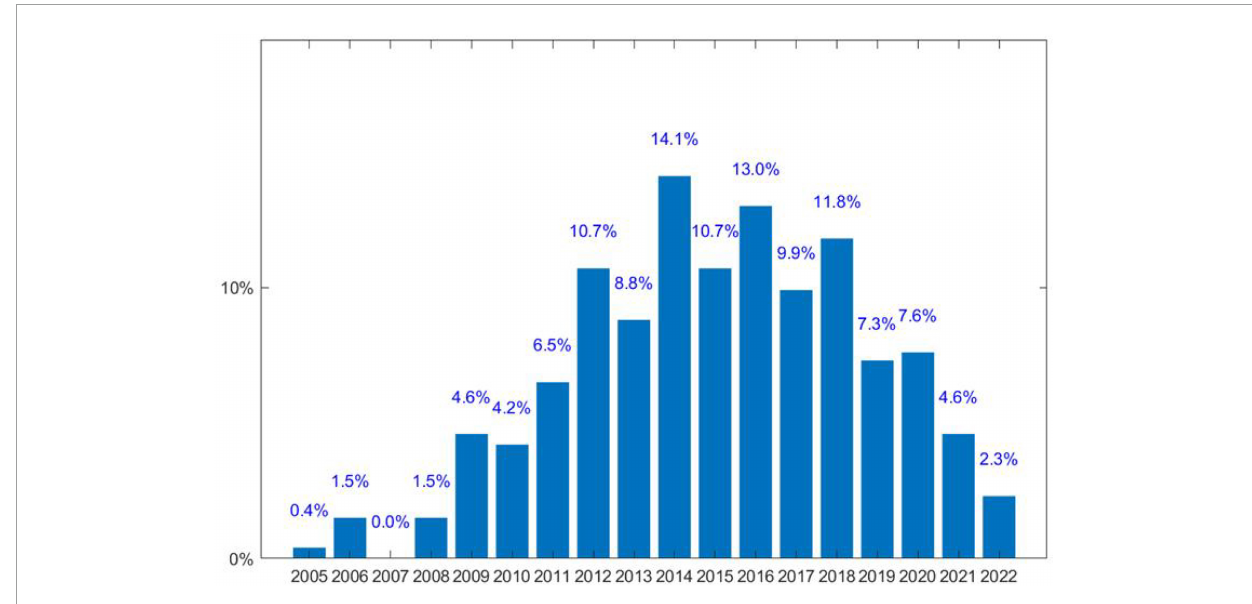
FIGURE4 Evolution of new social media use by companies in the energy and resources sector over